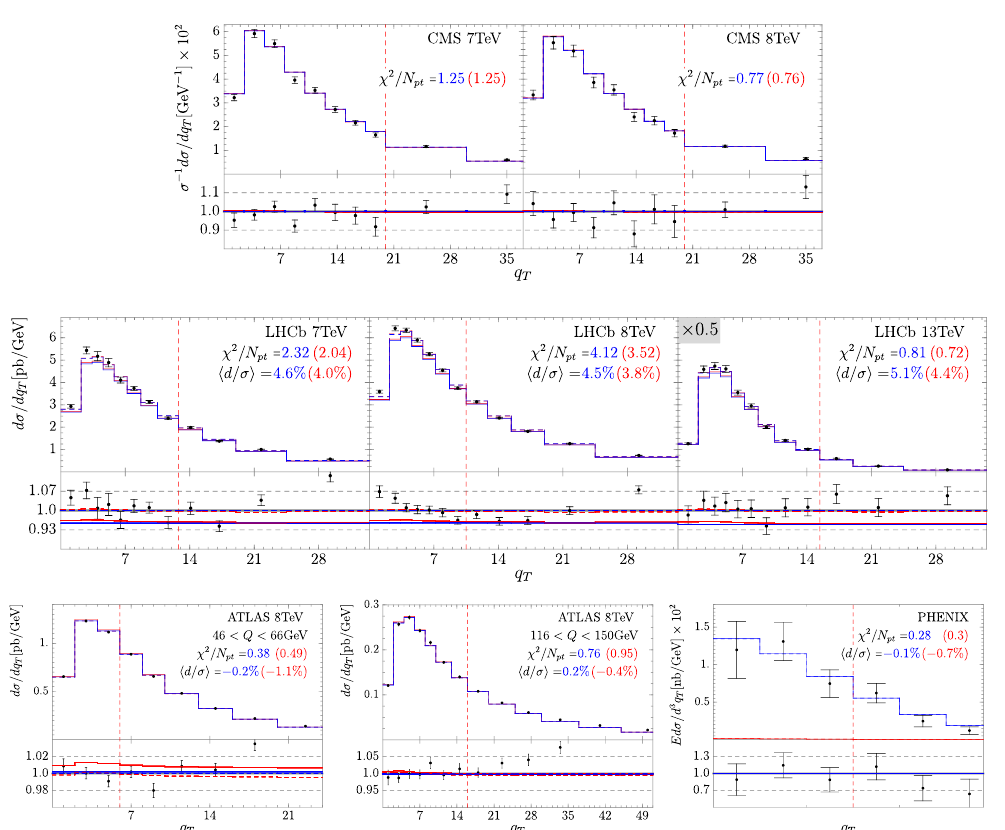
Figure 13 . Di(cid:11)erential cross-section for the Z=(cid:13) (cid:3) boson production measured by ATLAS, CMS, LHCb and PHENIX at di(cid:11)erent values of s and Q. The (cid:12)gure elements are the same as in (cid:12)gure 12.